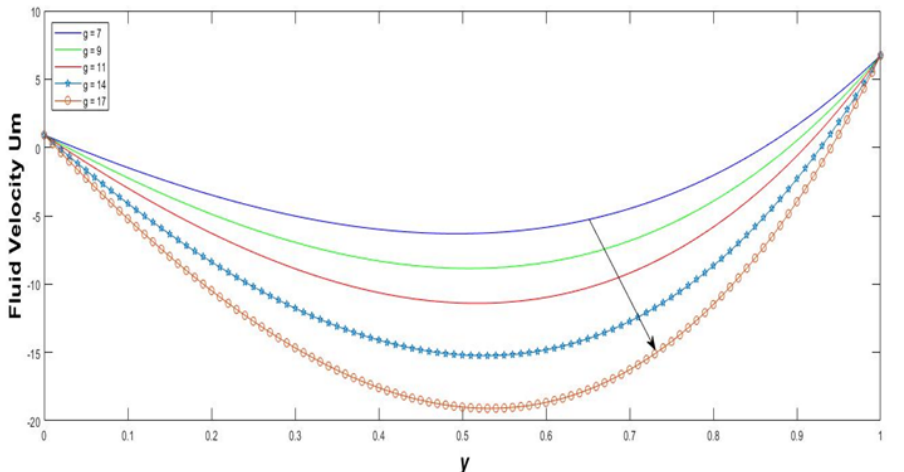
Figure 14. Velocity field for different injection/suction parameters.